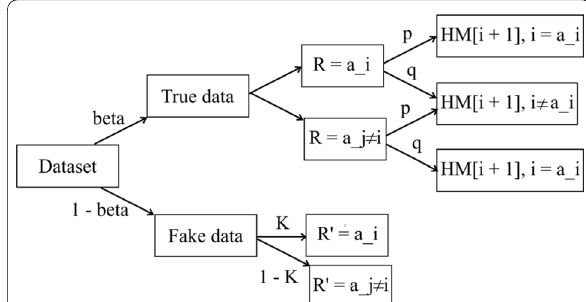
Fig. 3 The probabilities associated with the use of Hadamard Response as a privatization